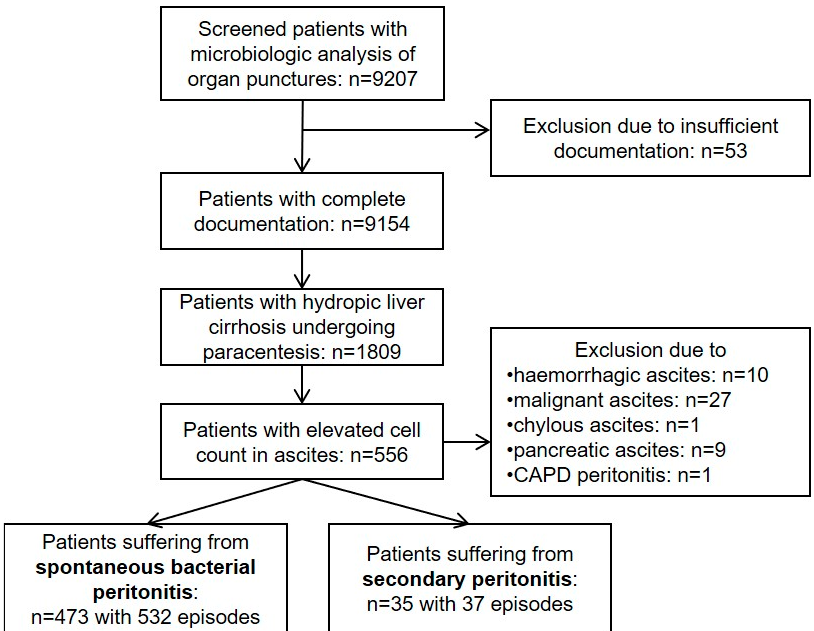
Figure 1. Flow chart of the screening and eligibility process of the study. CAPD, continuous ambulatory peritoneal dialysis.